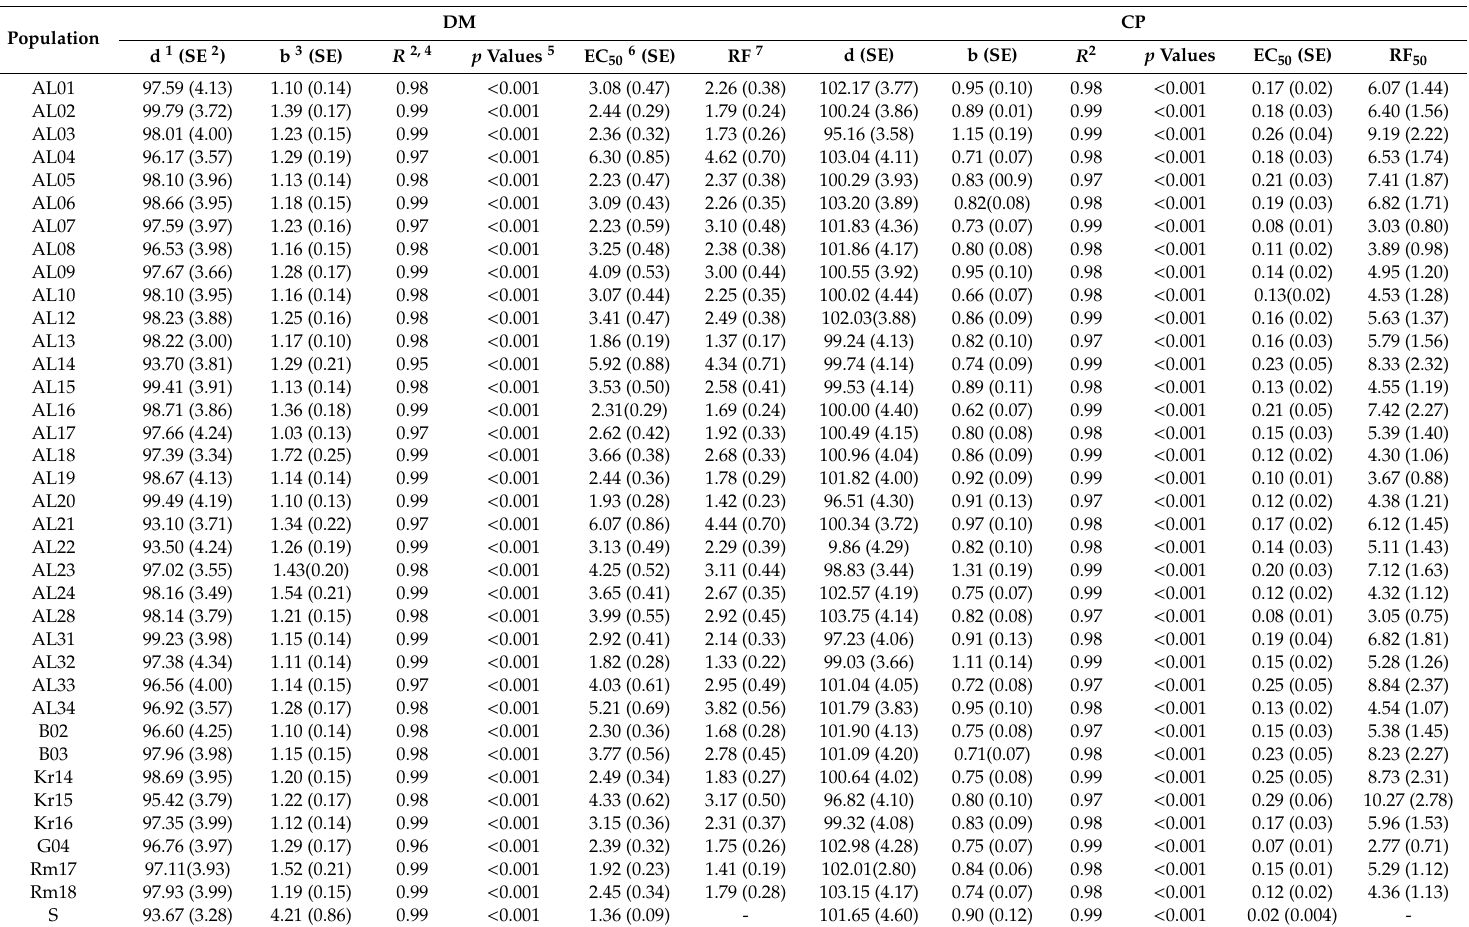
Table 2. Estimated nonlinear regression parameters and resistance factors (RFs) for the P. brachystachys in response to di ff erent diclofop-methyl (DM) and clodinafop-propargyl (CP)